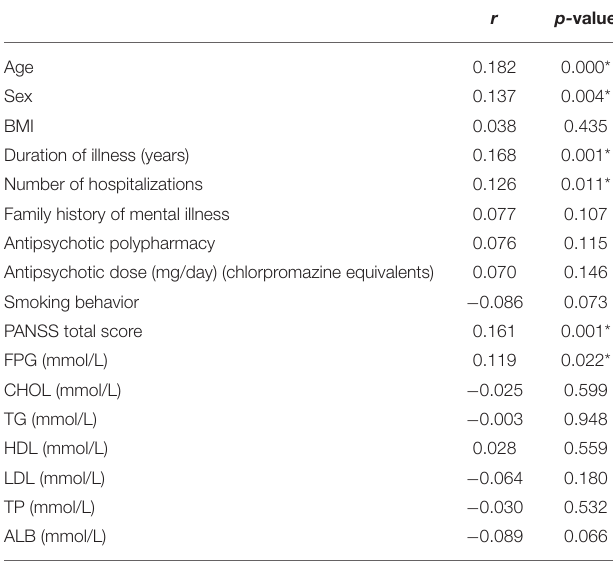
TABLE 4 | Result of Pearson and Spearman correlation analysis on correlation of